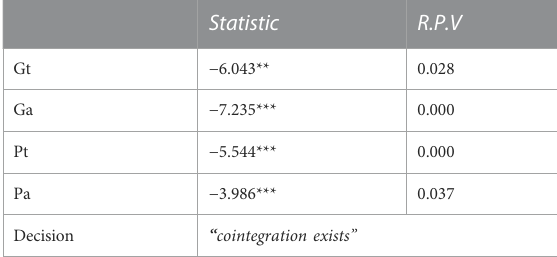
TABLE 5 Second generation